Question: Produce a descriptive caption suitable for publication.
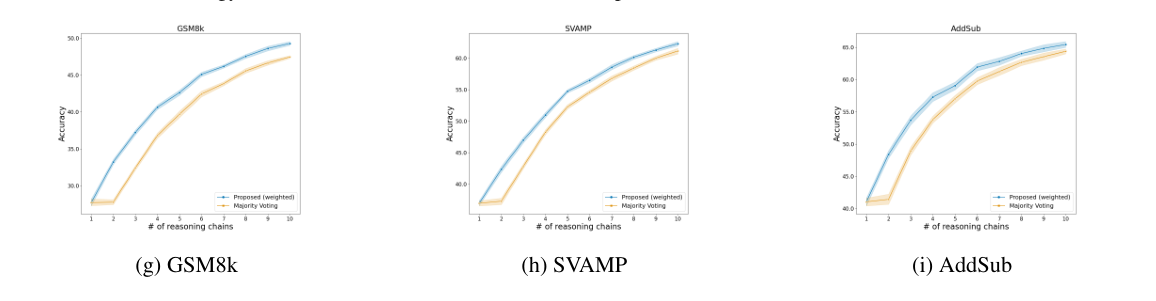
Answer: Self-consistency on the same reasoning chains, comparing between weighting the final answer using the scores from our proposed verifiers or taking the majority voting (↑). Overall, using the scores of our proposed verifiers to perform weighted voting consistently improves the final performance.